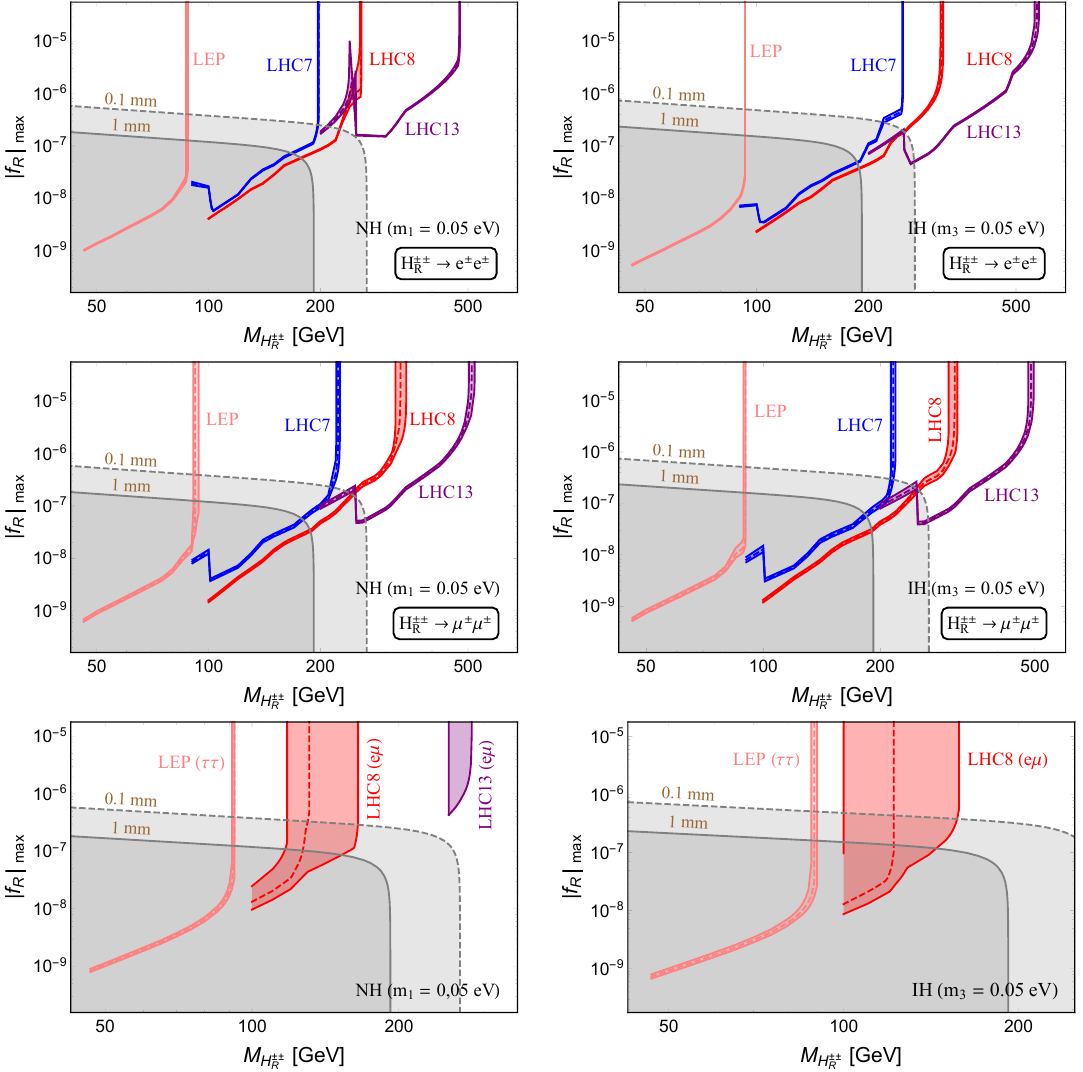
Figure 15 . Same as in (cid:12)gure 14, but for the lightest neutrino mass m 0 = 0 : 05 eV. The upper, middle and lower panels are respectively in the channels of ee, e(cid:22) , e(cid:22) and (cid:28)(cid:28) for both the NH and IH